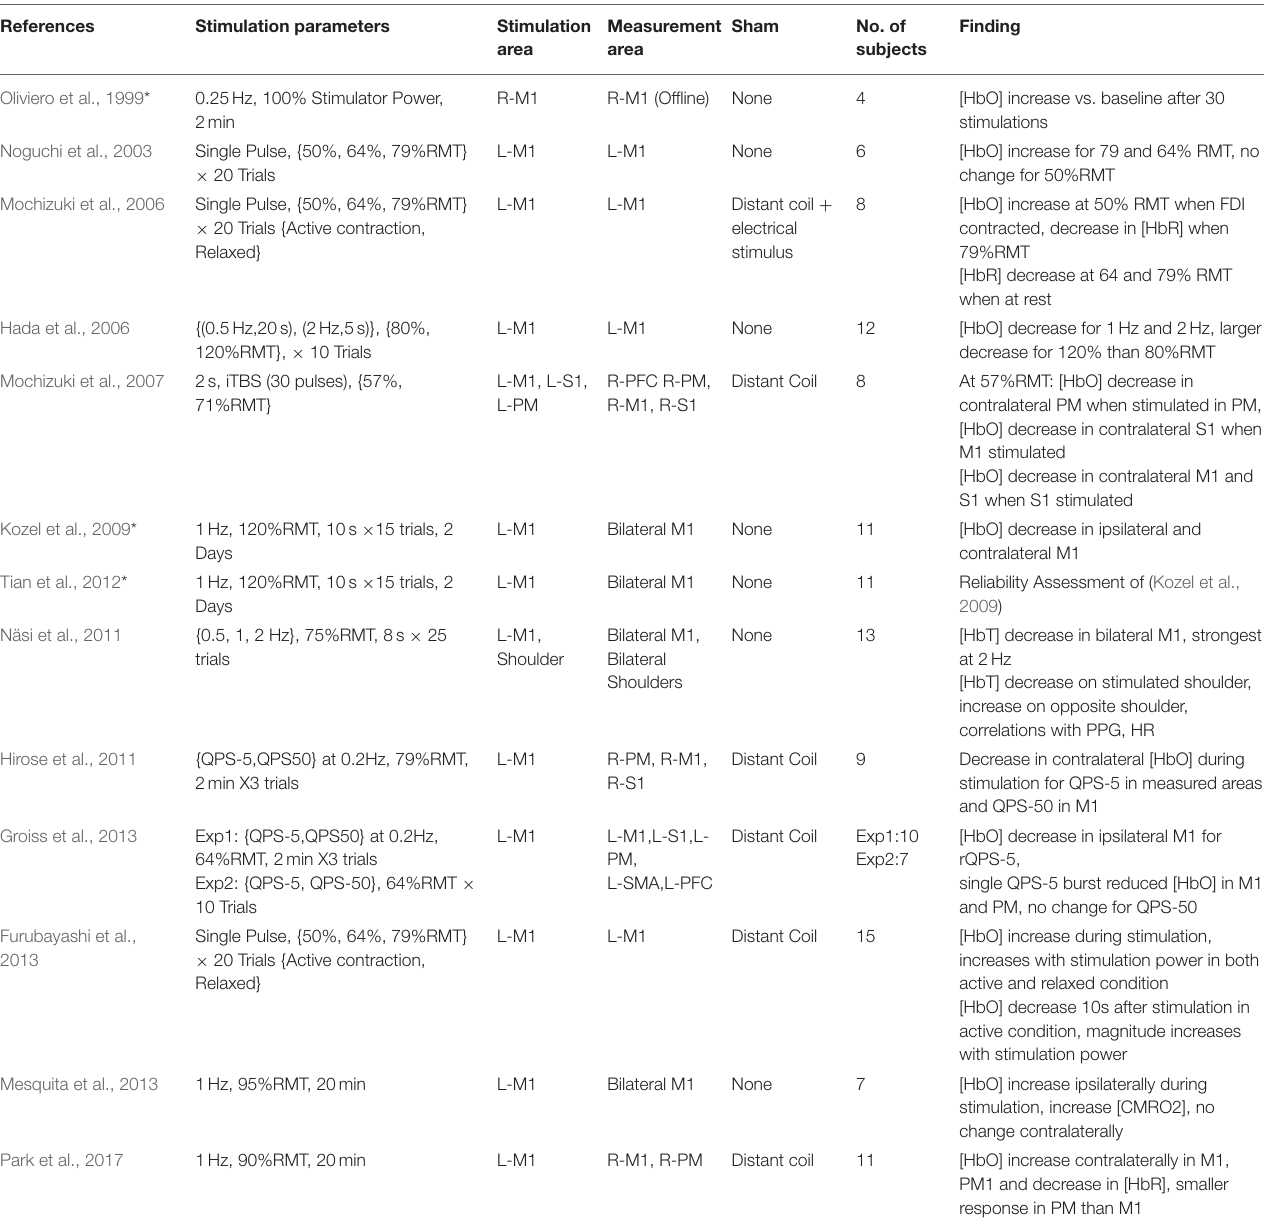
TABLE 1 | Studies investigating fNIRS-measured response to TMS stimulation of